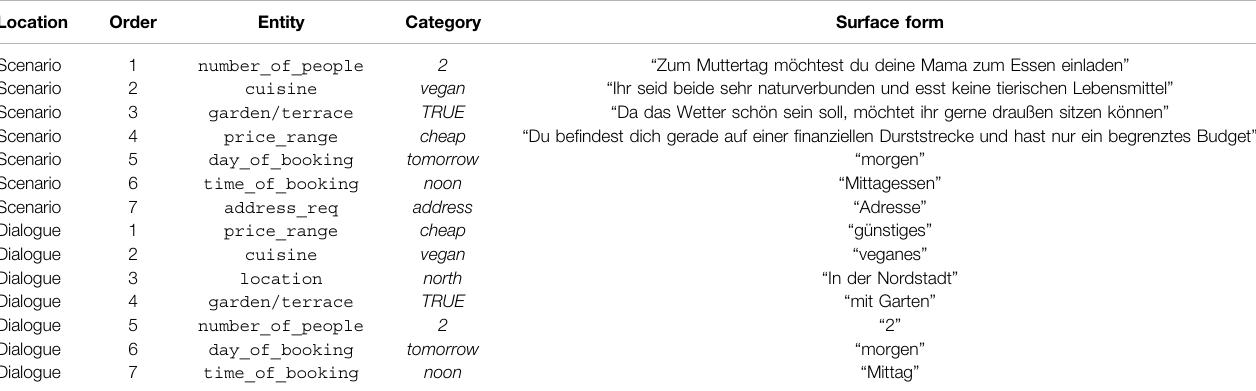
TABLE 3 | Entities in scenario and dialogue of CROWDSS example